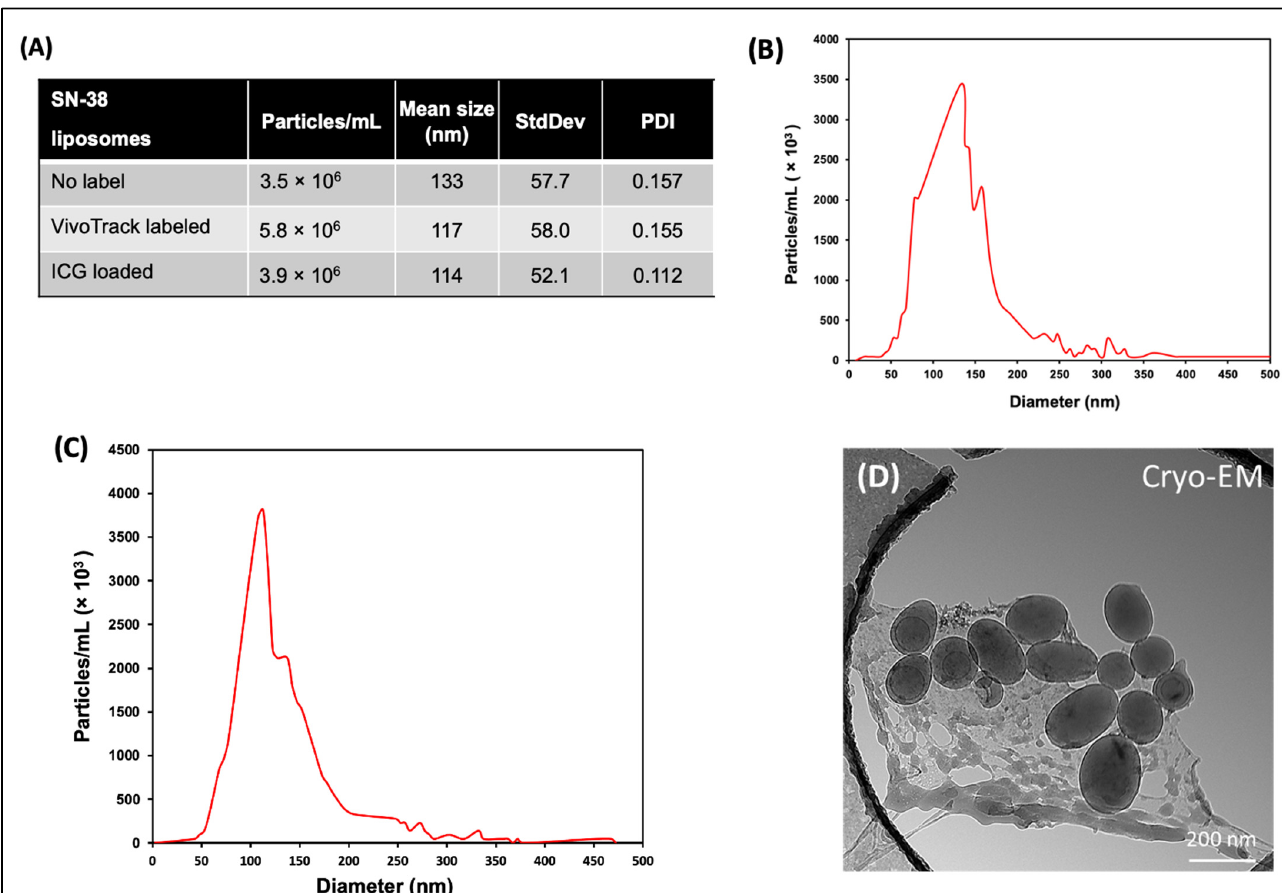
Figure 1. Physical characterization of RTLs produced by extrusion. ( A ) Table of liposome character- istics as measured by NTA at 25 °C. ( B–C ) Representative NTA plots the particle/mL vs. diameter for SN-38 loaded RTLs. ( D ) Cryo-TEM images of RTL liposomes containing PE:DSPC:Chol:DSPE-mPEG (Molar ratio 1:0.5:0.5:0.075).